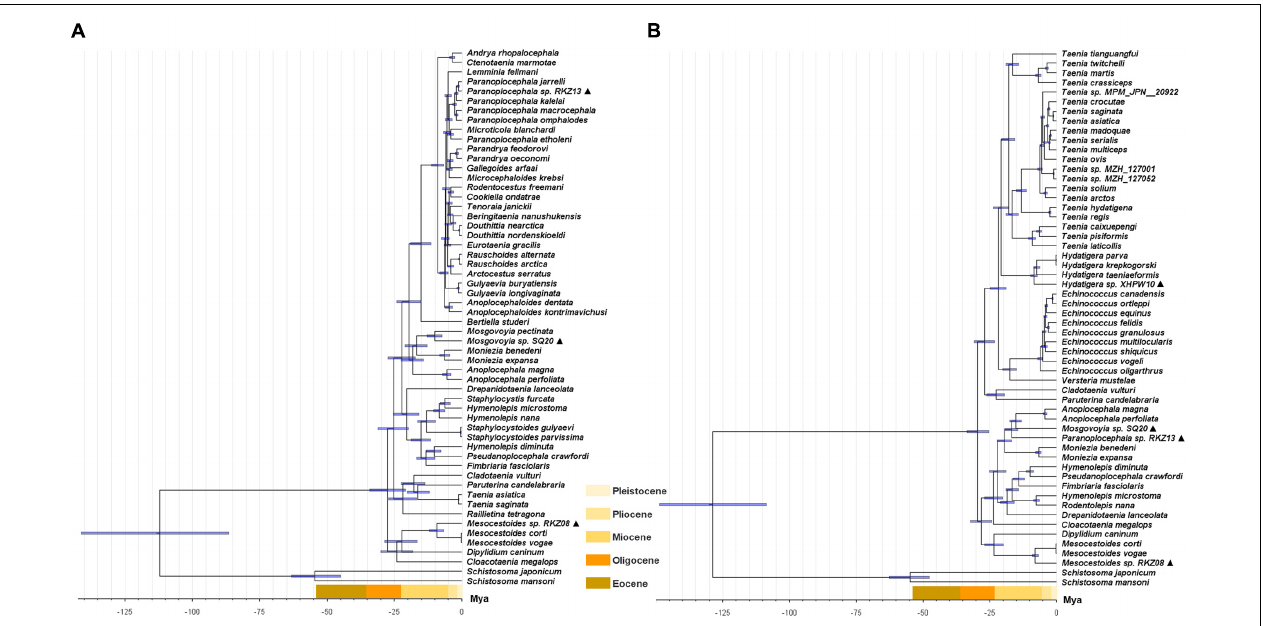
FIGURE 4 | Divergence time construction of concatenated cox 1 + nad 1 gene (A) and 12 mt PCGs (B) of Cyclophyllidea species. The (cid:78) after the species name represents “putative new species”. The blue bar represents interval of 95% highest probability density. The time scale bars in different colors shows the extent of the Eocene, Oligocene, Miocene, Pliocene, and Pleistocene period.